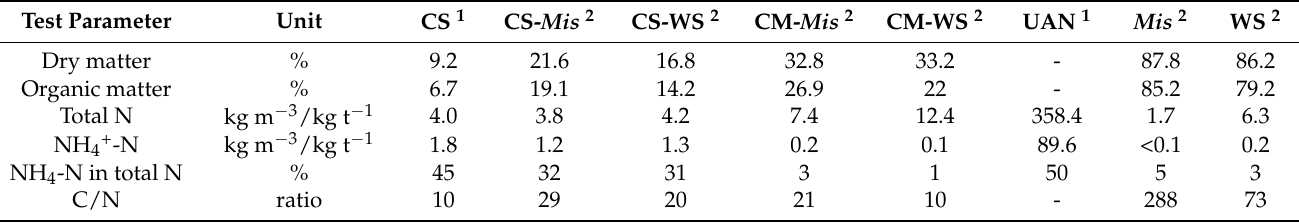
Table 3. Nutrient contents of the used treatments for experiment 1 (120 kg total N ha − 1 ) and experiment 2 (170 kg total N ha − 1 ), (CS = Cattle Slurry, CS- Mis = Cattle Slurry- Miscanthus (5 kg to 1 kg), CS-WS = Cattle Slurry-Wheat Straw (8.5 kg to 1 kg), CM- Mis = Cattle Manure from Miscanthus shredded bedding, CM-WS = Cattle Manure from Wheat Straw shredded bedding, UAN = Urea Ammonium Nitrate, Mis = Miscanthus -shredding, WS = Wheat